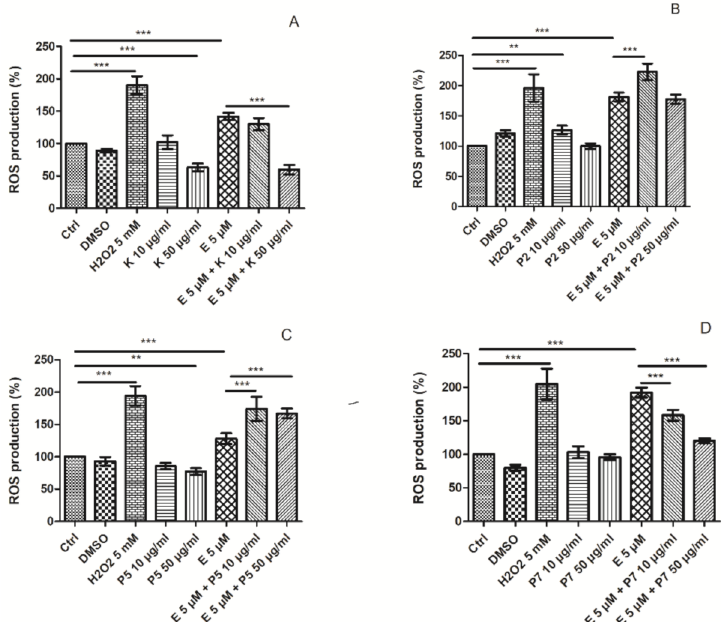
Figure 7. Reactive oxygen species (ROS) level in HL-60 cells incubated for 24 h at 37 ◦ C with 5 µ M etoposide (E) and 10 µ g/mL or 50 µ g/mL kaempferol (K) ( A ), P2 ( B ), P5 ( C ) and P7 ( D ) derivatives. The cells incubated with 5 mM H 2 O 2 for 15 min at 37 ◦ C were positive control. The figure shows mean results ± SD, n = 6; ** p < 0.01, *** p <